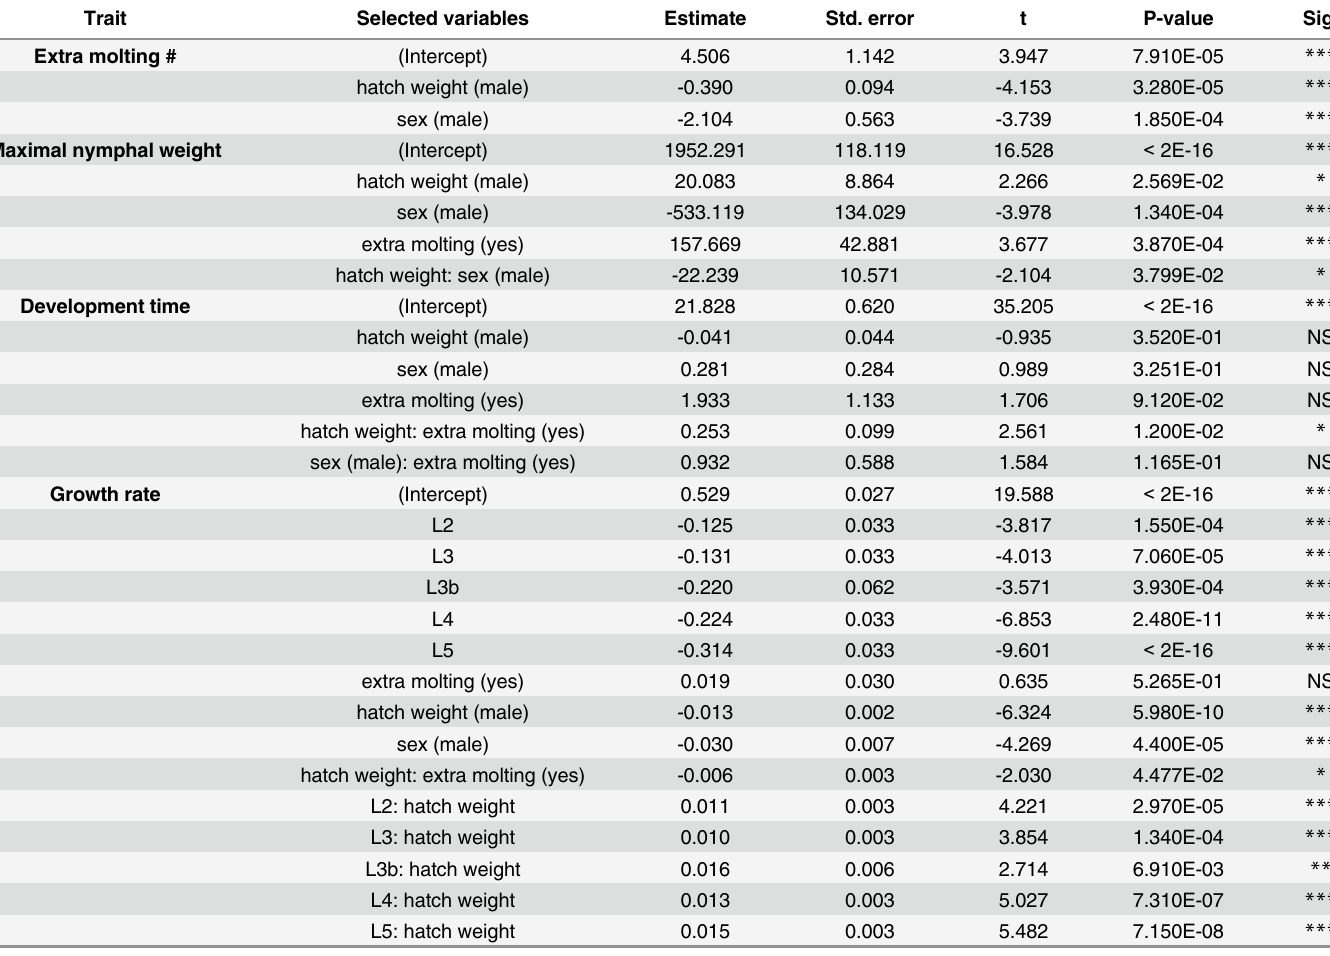
Table 2. Factors influencing nymphal development in S . gregaria . For each trait, selected variables came from linear models displaying the lowest AIC score, among all possible models including a null model and a full model (i.e., containing all variables as well as every simple interaction between pairs of var- iables; see Methods). Note that for extra molting and for growth rate we used GLMs with logit link function and linear mixed model, respectively. We report estimates, standard deviations, t values (except for extra molting; #: z values) and P -values associated with each variable (and intercepts). For growth rate, L2, L3, L4 and L5 refer to 2nd to 5th nymphal instars. L3b refers to the added nymphal instar for individuals undergoing extra